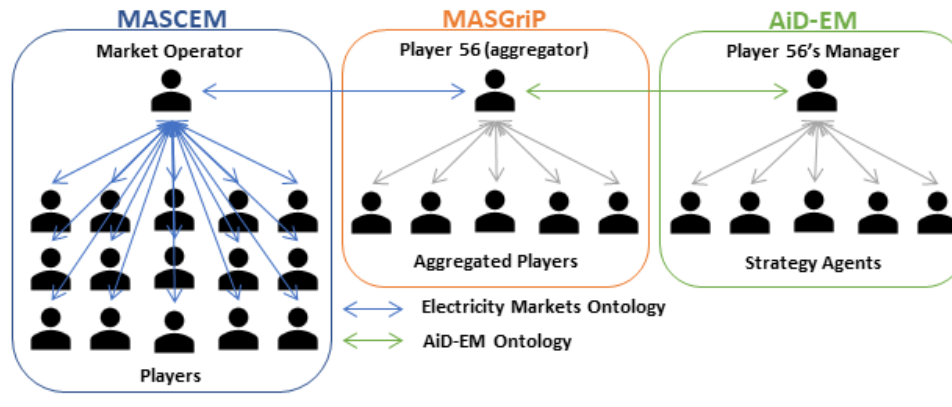
Figure 5. Interaction between multi-agent